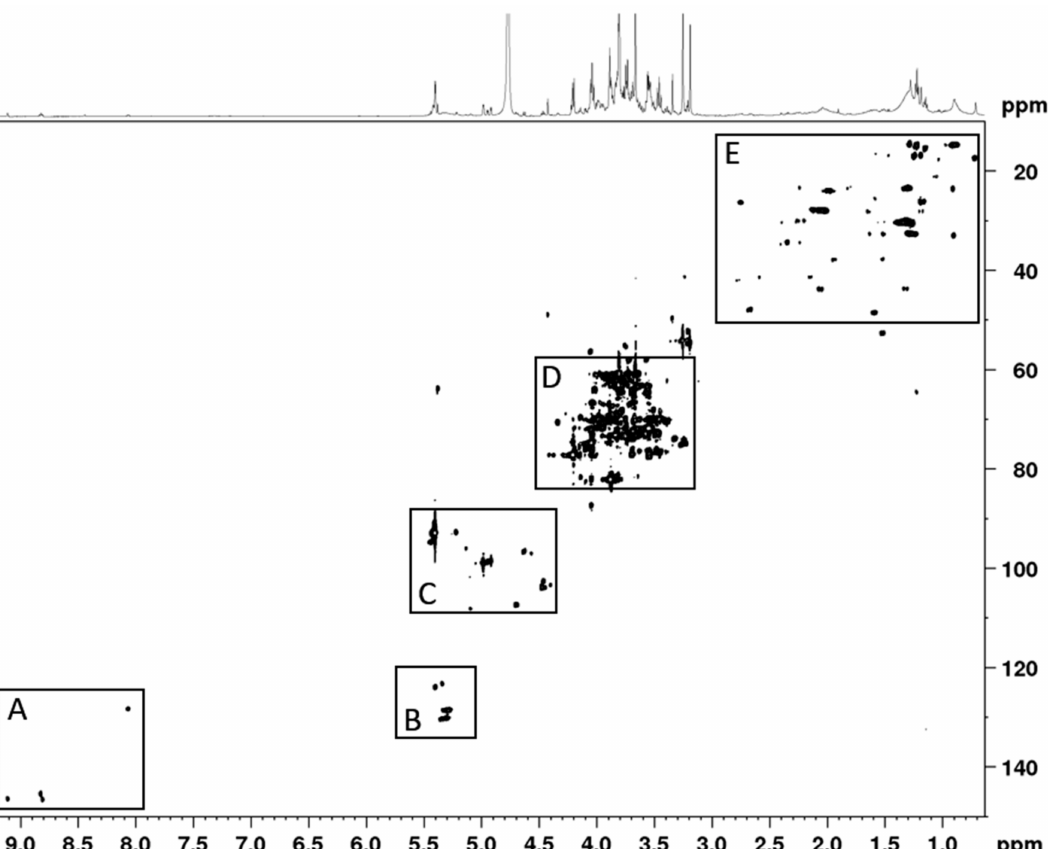
Figure 3. The HSQC (Heteronuclear Single Quantum Coherence) spectrum shows that the AC extract consists primarily of sugars, and of minor amount of polyphenols and amino acids. The 1 H- 13 C-HSQC spectrum shows the C 2 /H 2 to C 6 /H 6 sugar ring signals (region D); the anomeric C 1 /H 1 sugars signals (region C); olefinic signals (region B); aromatic/polyphenol signals (region A); and methyl, methylene, methine signals (region